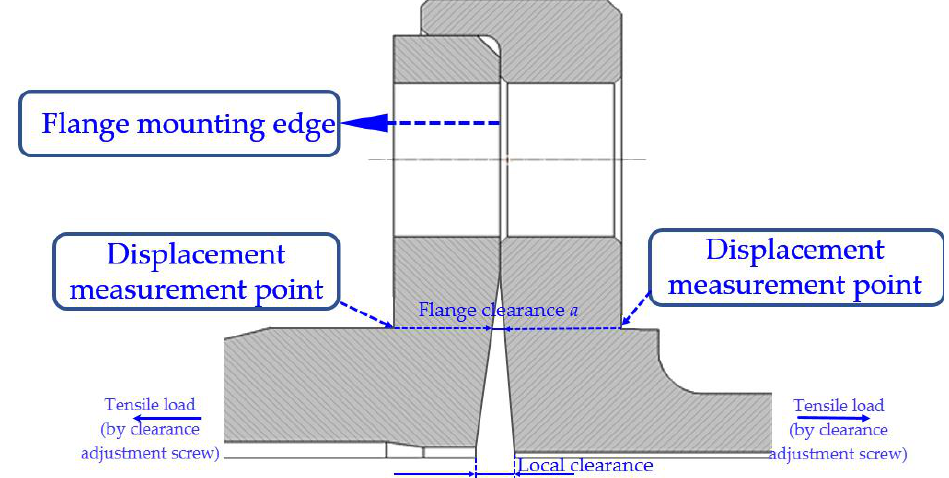
Figure 8. Schematic diagram of the flange clearance ( a ).